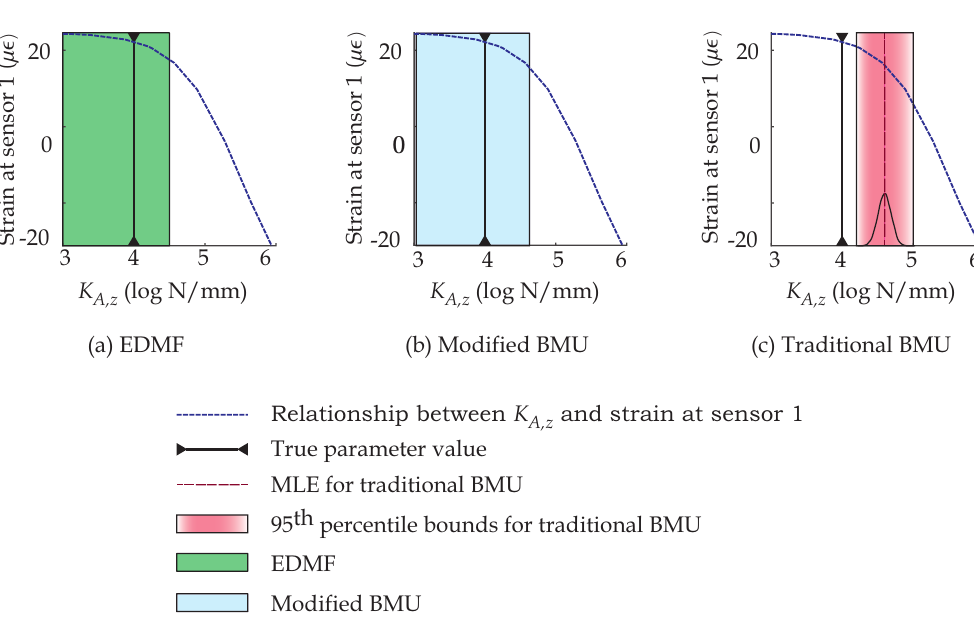
Figure 7. Updated knowledge of parameter K A , z obtained through structural identification with measurements before retrofit actions (Case 2 in Table 4). EDMF and modified BMU provide updated bounds for parameter K A , z , while traditional BMU provides an informed (inaccurate) marginal PDF of K A , z